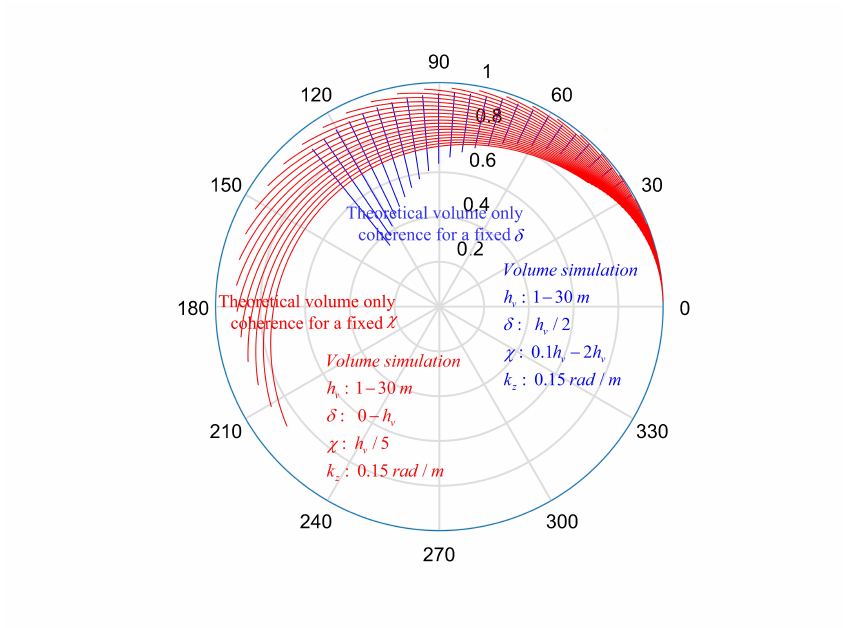
Figure 3. The solution space of Gaussian vertical backscatter model when δ or χ is fixed. Each blue or red curve represents the volume only coherence for a given forest height at an interval of 1 m. The terrain slope is set to